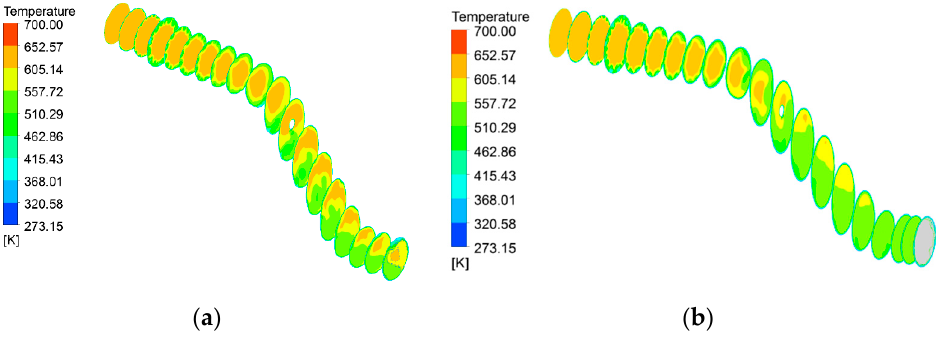
Figure 7. The temperature distribution: ( a ) the double-layered pipe; ( b ) the single-layered pipe. The thermal insulation of the front exhaust pipe will affect the chemical reaction in the post-processing device, and the flow velocity in the front exhaust pipe reflects the resistance and energy loss of the exhaust. After passing through the nozzle, the velocity distribution begins to be asymmetrical. This result is same as the study of Qiu [28], which verifies the effectiveness of our work. According to the study of Qiu, the asymmetrical velocity distribution might be because the UWS broke into droplets. The droplets are subjected to random motion in the coupling space by the effect of the swirling air. This random motion breaks the symmetry of the velocity distribution. By analyzing the velocity field distribution of the single-layered pipe and the double-layered pipe, it can be seen that the velocity difference between the inlet and outlet of the double-layered pipe was 3.7 m/s, and the velocity difference between the inlet and outlet of the single-layered pipe was 4.41 m/s. The velocity difference between the inlet and outlet of the double-layered pipe was 16.1% lower than that of the single-layered pipe. This indicates that the flow resistance in the double-layered pipe was further reduced. As shown in Figure 8, in the exhaust bellow part, the velocity distribution of the two was almost the same. In the exhaust bellow, the velocity near the corrugation was lower than that of the middle. The velocity changes greatly near the nozzle. The velocity distribution in the double-layered pipe was more uniform than that of single-layered pipe, which improved the velocity distribution of the front exhaust pipe. The flow resistance and energy loss of exhaust was reduced in the double-layered pipe.